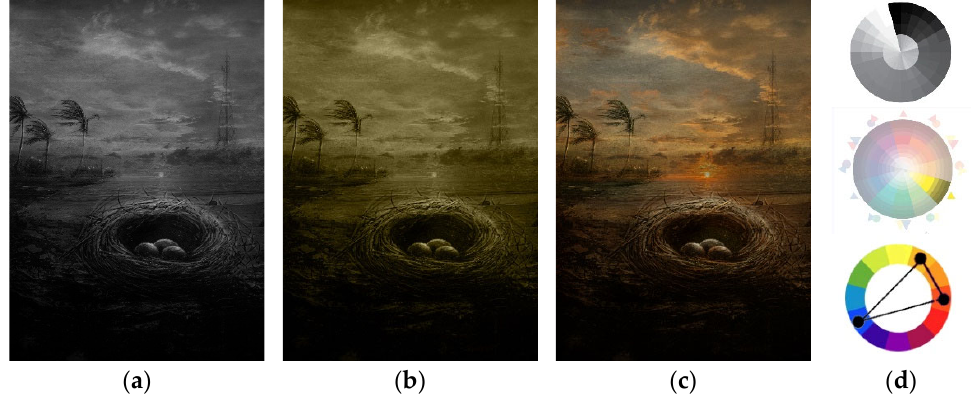
Figure 2. The egg imagery inspires life and growth, whereas technology does not guarantee safety or a better life: ( a ) Black ‐ and ‐ white concept; ( b ) Monochrome concept; ( c ) Color concept; ( d ) Color or a better life: ( a ) Black-and-white concept; ( b ) Monochrome concept; ( c ) Color concept; ( d ) Color wheel concept of each image. wheel concept of each